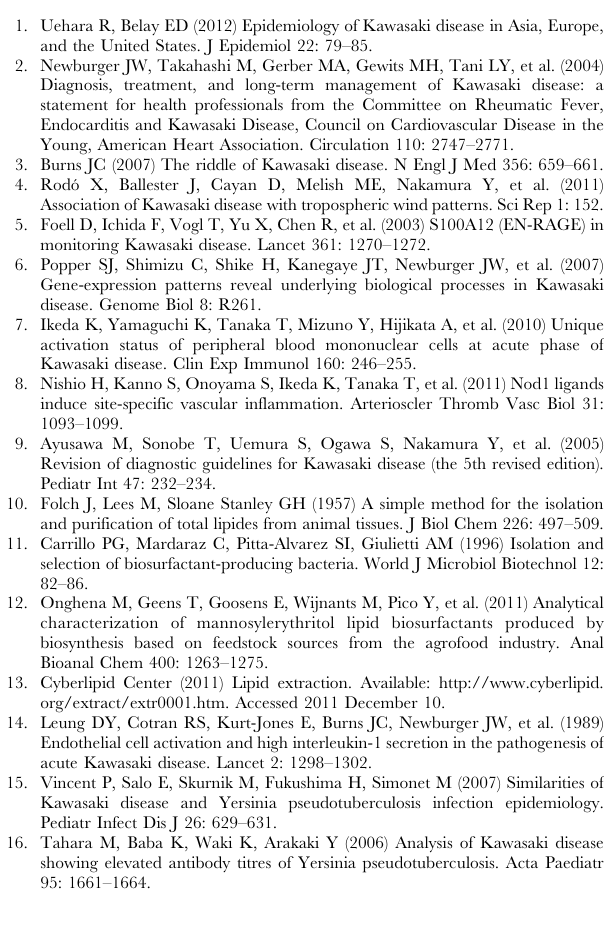
Figure S2, Effects of biofilm formation, shaking time and various oils on the production of a KD-specific MAMP by LC-MS analysis. Figure S3, LC-MS and MS/MS analyses of 3 KD- specific molecules with IgG sepharose-binding activity. Table S1, Detection rates of spore-forming and pathogenic microbes in the oral cavity and upper respiratory tract of KD patients. Table S2, Presence of MAMPs in various microbes similar to serum KD- specific molecules. Table S3, Common MAMPs between the in vivo biofilms and sera in respective KD patients at the 2 nd study. Table S4, Common MAMPs between the in vivo biofilms and sera, and microbes detected in respective KD patients at the 3 rd